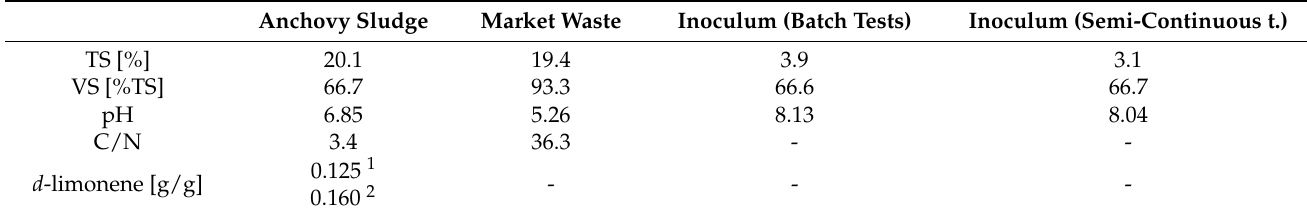
Table 1. Substrates and inocula